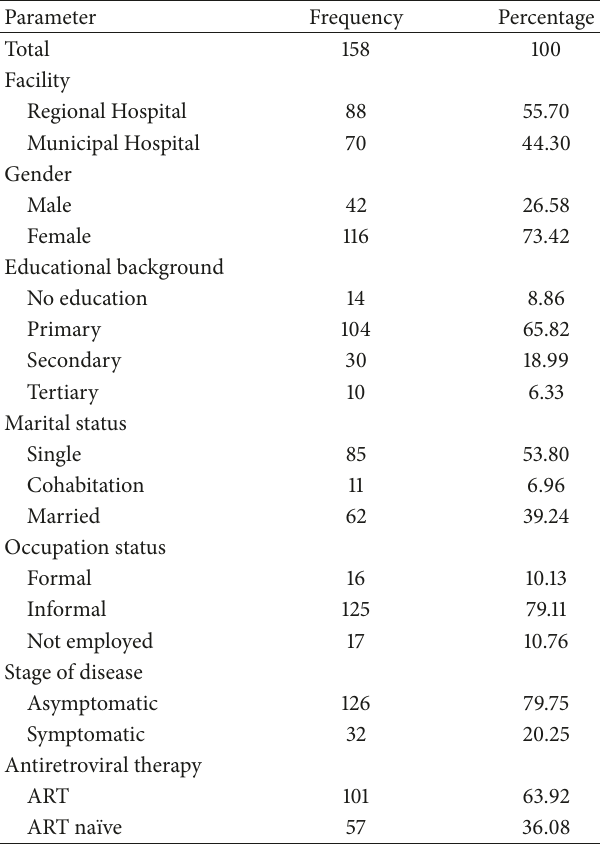
Table 1: Sociodemographic characteristics of people living with HIV/AIDS in Ho